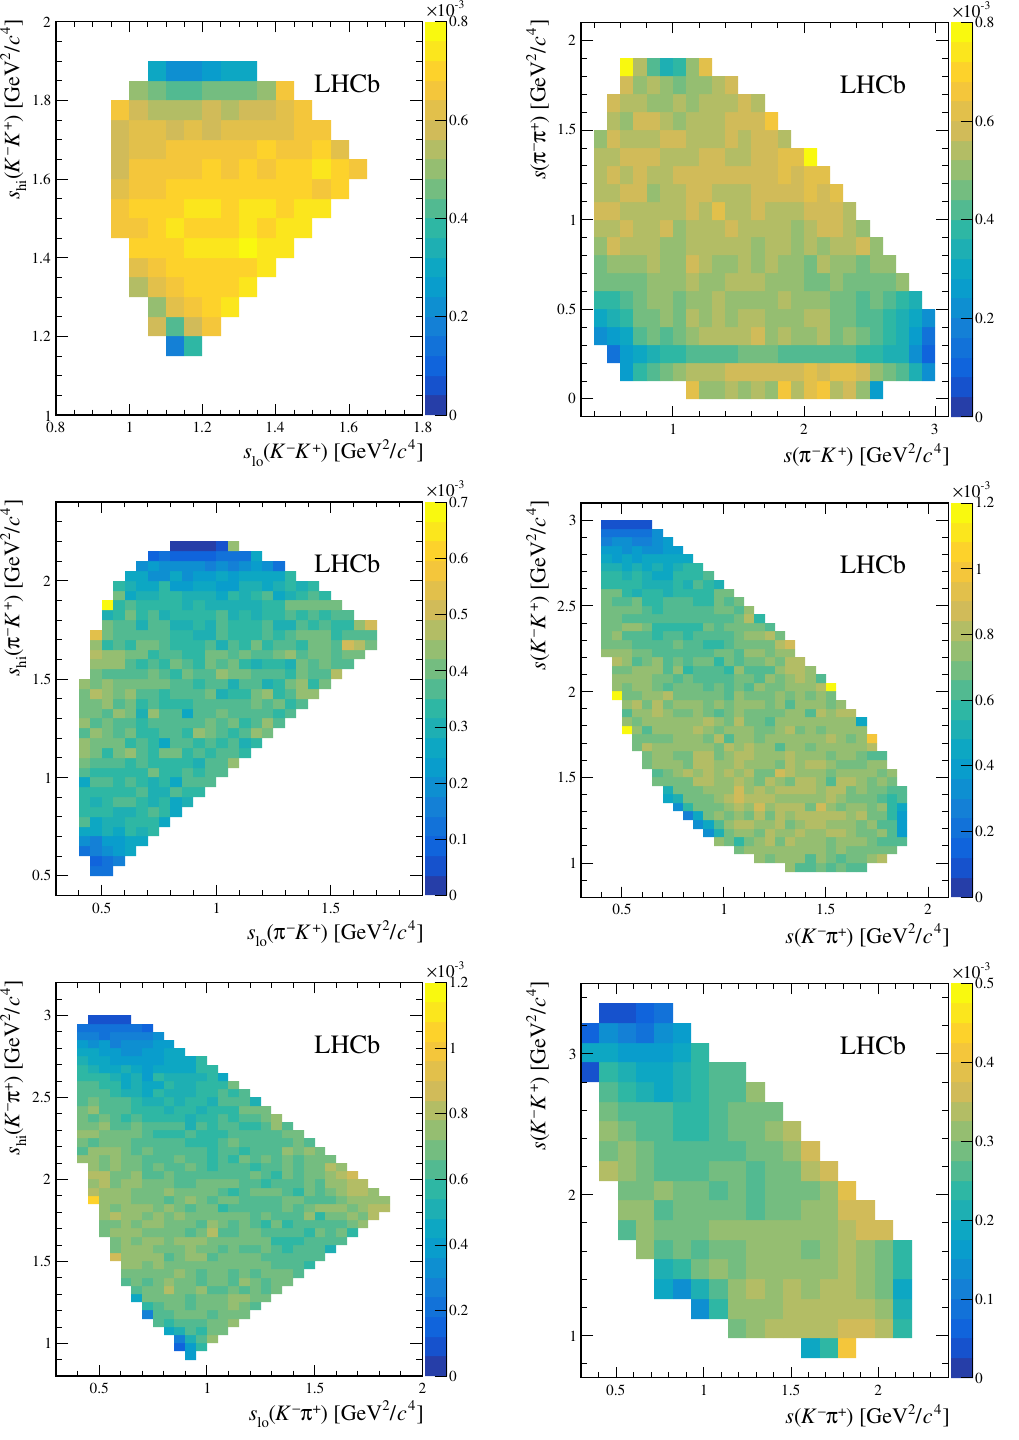
Figure 2 . E(cid:14)ciency maps for (top left) D + ! K (cid:0) K + K + , (top right) D + ! (cid:25) (cid:0) (cid:25) + K + , (middle left) D + ! (cid:25) (cid:0) K + K + , (middle right) D + ! K (cid:0) K + (cid:25) + , (bottom left) D + ! K (cid:0) (cid:25) + (cid:25) + and (bottom s right) D + ! K (cid:0) K + (cid:25) + decays with PID e(cid:14)ciency, tracking, multiplicity and hardware trigger s e(cid:14)ciency corrections, for MagDown polarity.